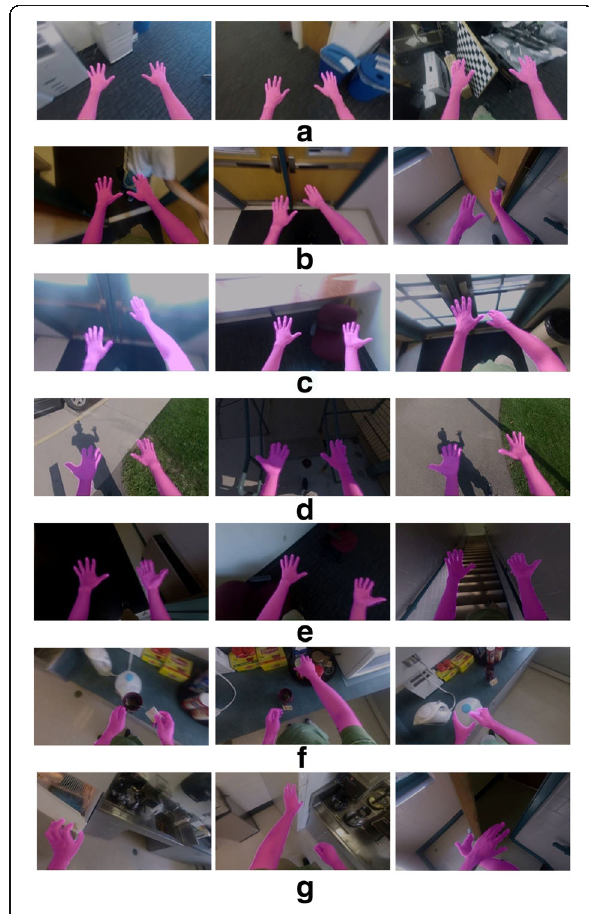
Fig. 1 Results of proposed method in challenge cases. From a – g are cases of hands are motion blur, background having skin-color, frames are overexposed, hands in contrast shadow, frames are underexposed, hands interacting with objects, and hands in varying